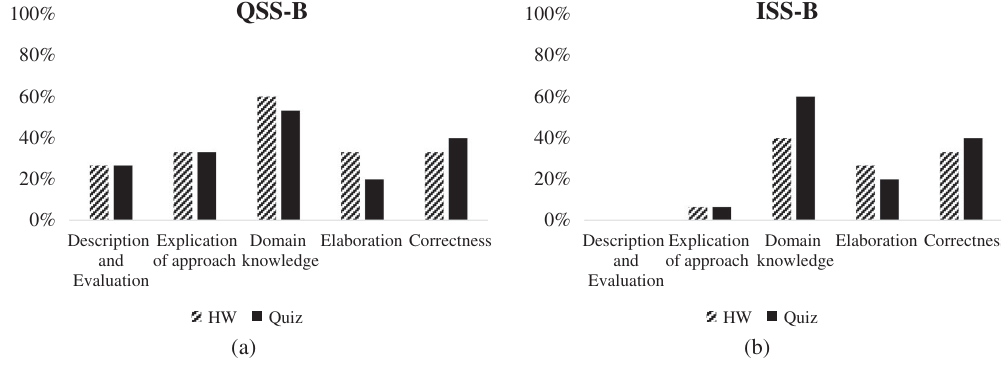
FIG. 9. (a) Percentage of TAs who graded on solution features in the five clusters on the brief QM solution QSS-B in the homework and quiz context. (b) Percentage of TAs who graded on solution features in the five clusters on the brief introductory physics solution ISS-B in the homework and quiz context ( N ¼ 15